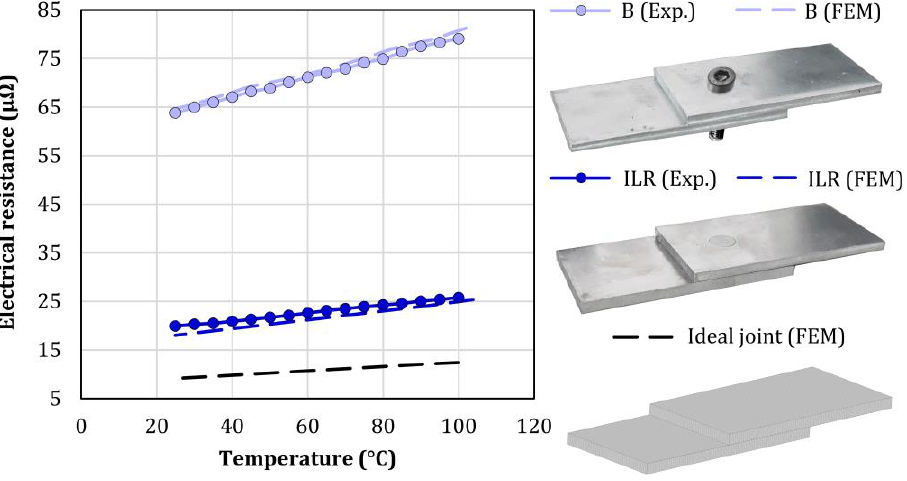
Figure 11. Experimental and finite element predicted evolutions of the electrical resistance with temperature.